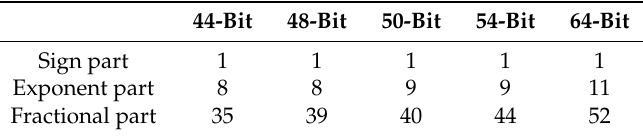
Table 2. Format of floating-point.